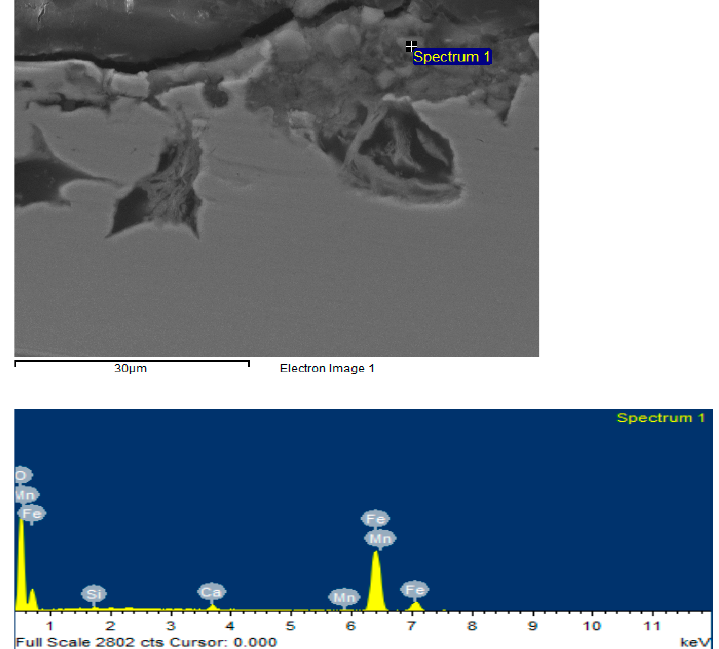
Figure 10. Surface image and elemental composition for the sample (test speed 720 rpm) obtained with CEM.